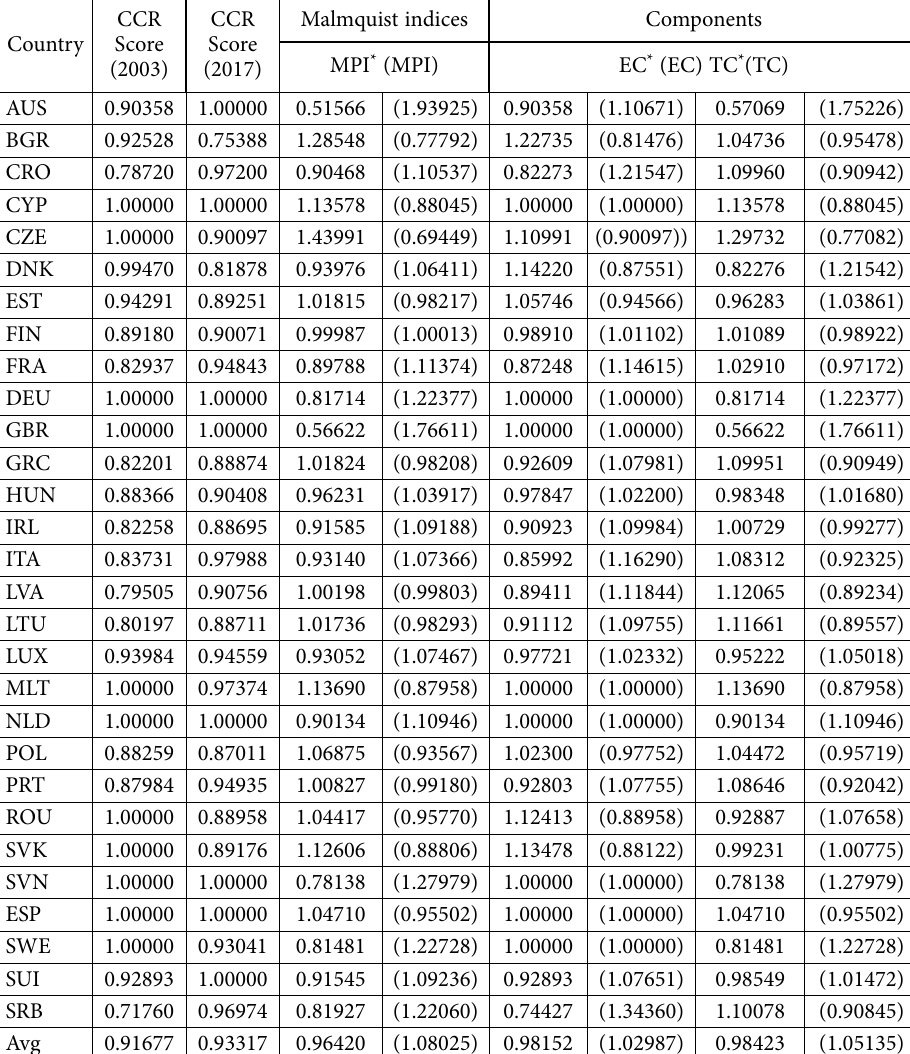
Table 4. Efficiency scores and productivity changes (source: calculated by the authors based on data from Universal Postal Union (2019))